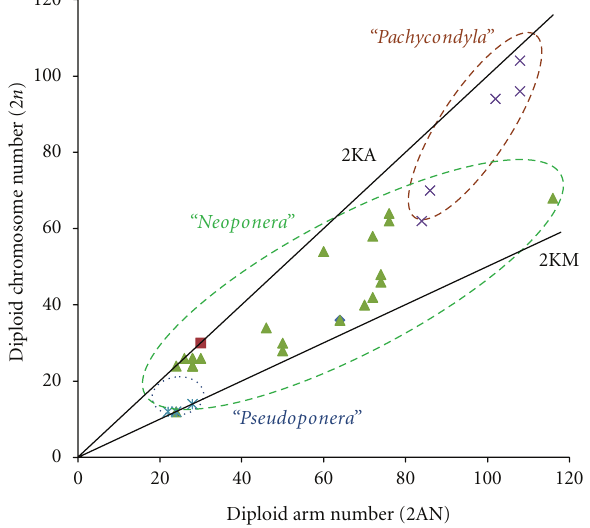
Figure 4: Karyograph of the Neotropical Pachycondyla sensu Brown. The ellipses circle the more representative species groups of our sampling according Schmidt [7] (see Table 1); two isolated points (square, diamond) represent single taxa not incorporated in a group ( P. arhuaca , P. constricta ).